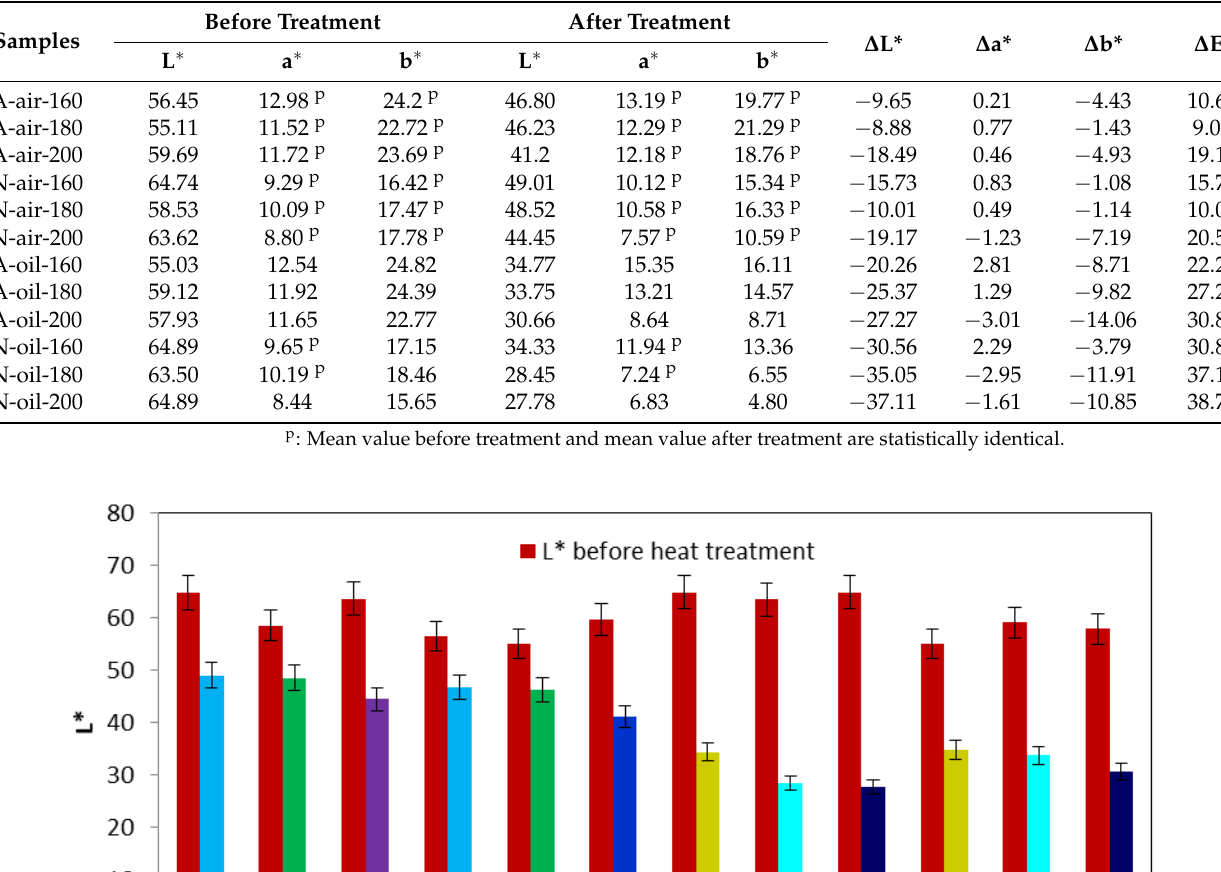
Figure 2. Wood samples before and after heat treatment. 3.2. Weight Change The weight changes occurred during Afrormosia and Newtonia heat treatment are presented in Figures 3 and 4. The loss in mass was only observable for the cases of ther- mal treatment under air conditions. As shown in Figure 3, the weight loss increased with the treatment temperature regardless of the species of wood, mainly due to the decrease with temperature, of the quantity of polysaccharides related mainly to the degradation of hemicelluloses [38]. Čabalová [44] goes further, stating that it is the degradation of Xy- lose, D-galactose, L-arabinose and D-mannose type polysaccharides that are responsible for the loss of wood mass during heat treatment. Moreover, at 200 °C, the three previ- ously mentioned polysaccharides are completely degraded [38,46], which explains why we found in our study that the maximum losses was observed for the heat treatments carried out at the temperature of 200 °C and reached 1.81% and 1.71%, respectively, for Newtonia and Afrormosia.